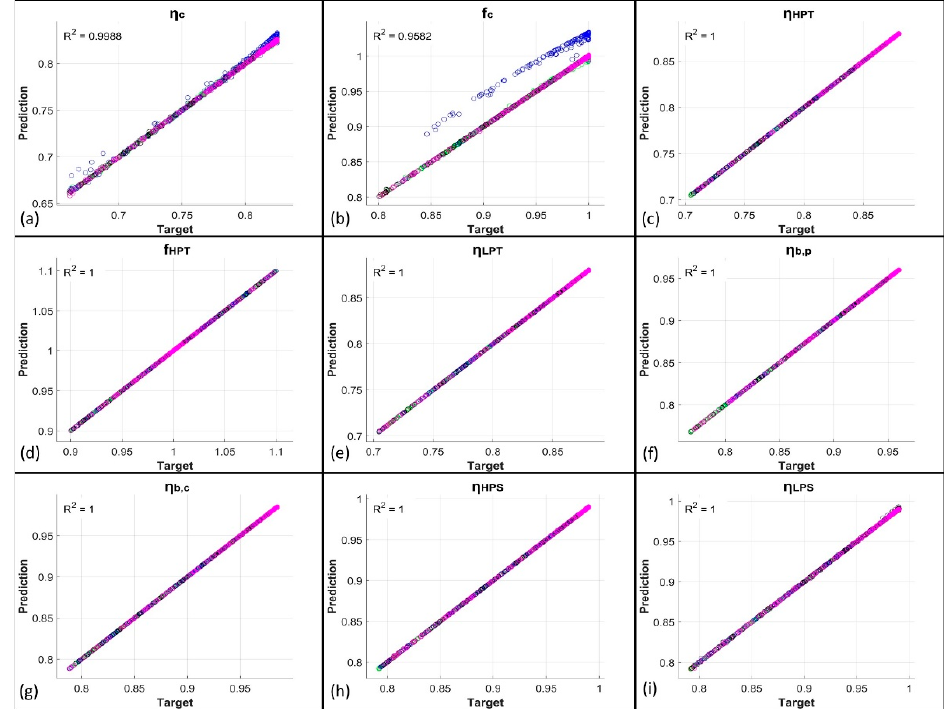
Figure 3. ( a – i ) Comparison between FFNN predictions and targets about the PPs related to the first five degradation conditions. Grey: START-A; brown: START-B; green: MAXPOW-A; blue: MAXPOW-B; black: MAXDUR-A; magenta: MAXDUR-B.